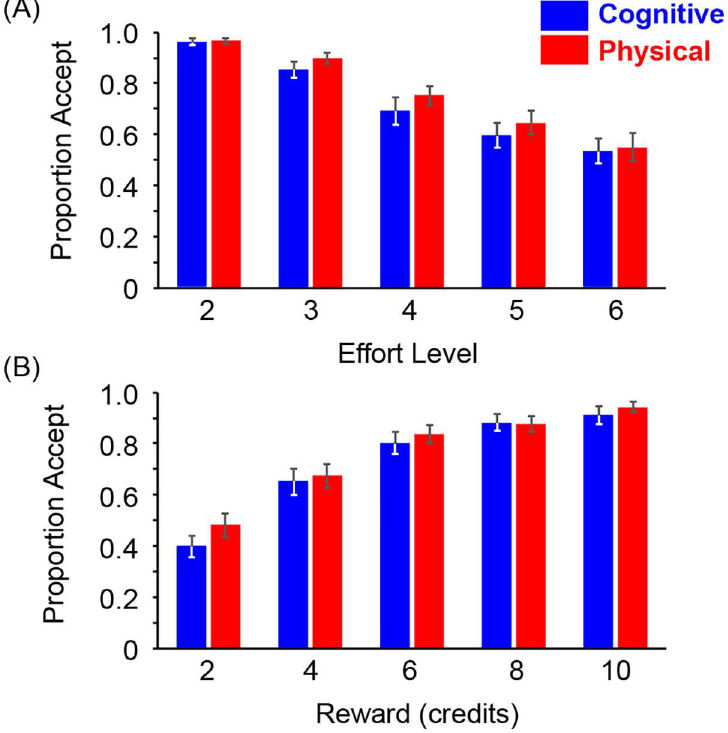
Fig 2. Group data reveal similar choice behaviour for cognitive and physical effort. Proportionof acceptedoffers ( ± 1 standarderror of the mean [SEM]) as a function of (A) effort and (B) rewardfor the cognitiveand physicaleffort tasks. Underlying data for panels A–B can be found in S1